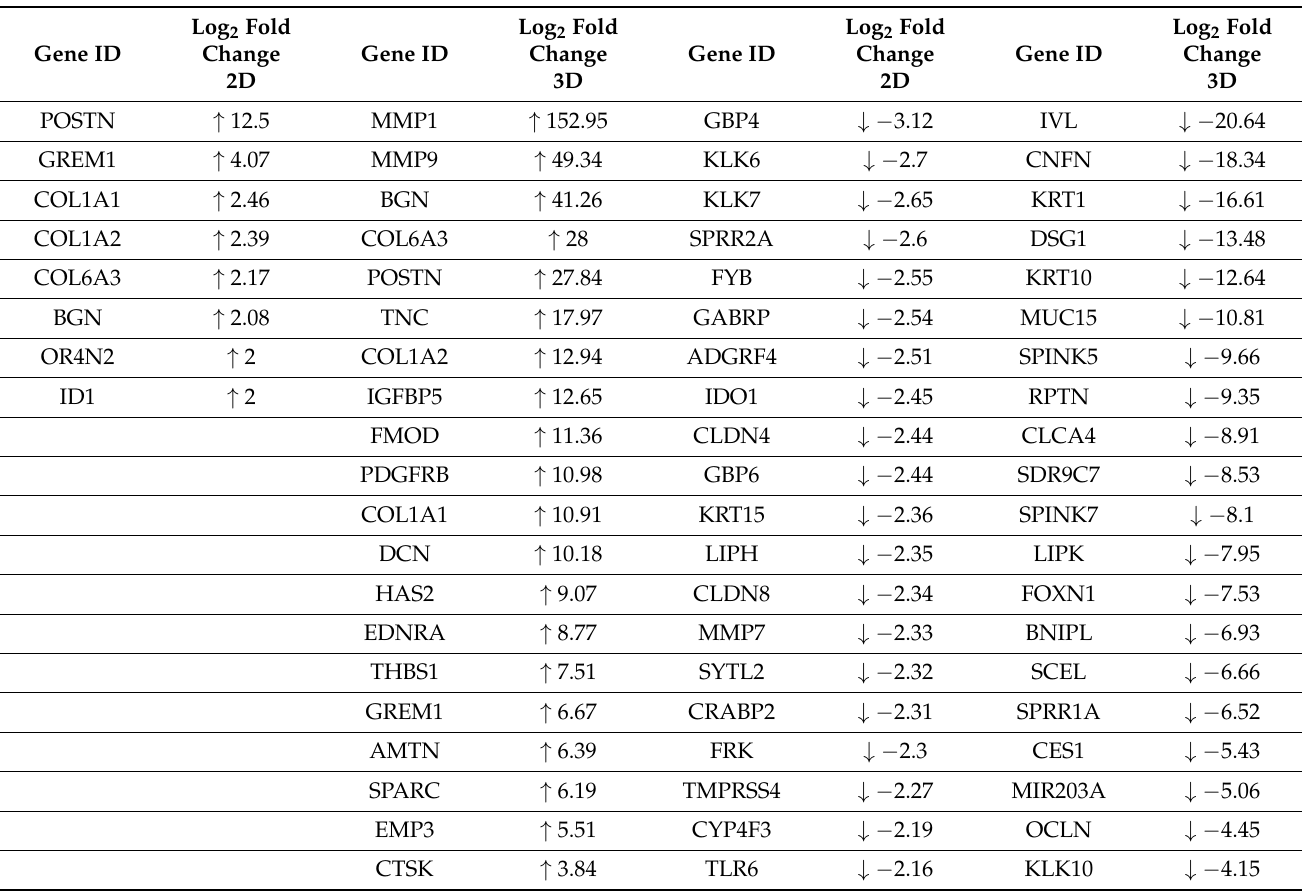
Figure 1. Co-culture of tumor cells and cancer-associated fibroblasts in 2D. Cells of the head and neck squamous cell carcinoma cell line LK0923 were co-cultured with their patient-matched cancer- associated fibroblasts (CAFs) ( A ) or cultured alone ( B ) for 7 days. Fibroblast-rich areas (F). The microarray data analysis revealed eight genes that were upregulated while 38 genes were downregulated (Table 1 and Table S3, Figures S6 and S7). The majority of these expression differences were deduced on the basis of the fold-change alone and had a relatively large biological variability due to the treating of independently derived cell line as biological replicates in the experiment. Table 1. Altered genes in 2D and 3D co-culture of HNSCC cells with CAFs. Only the top 20 genes listed from the 3D experiment.